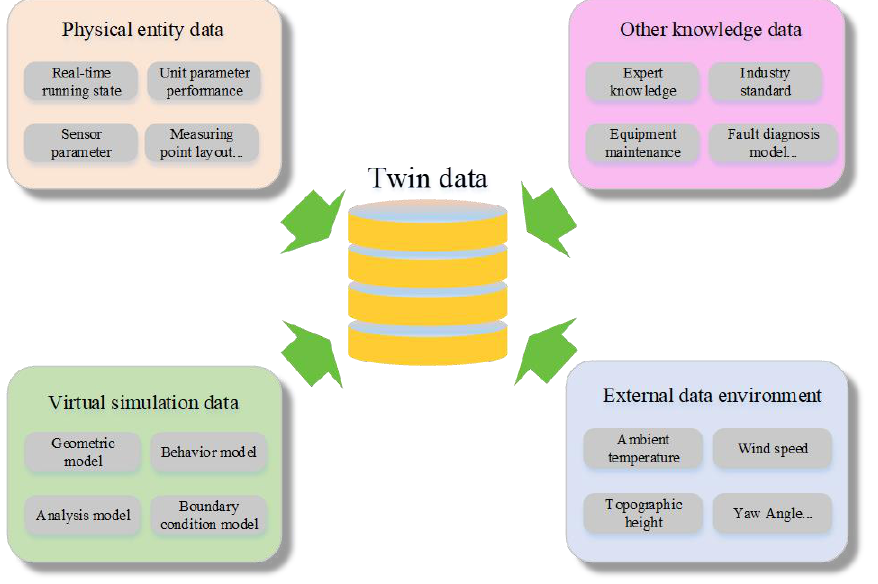
Figure 4. Data components of the wind turbine drive system.